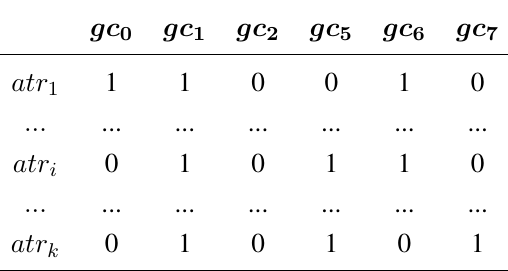
specifies the i -th grid cell and i ) are cached in the memory of the SN, while 0 1